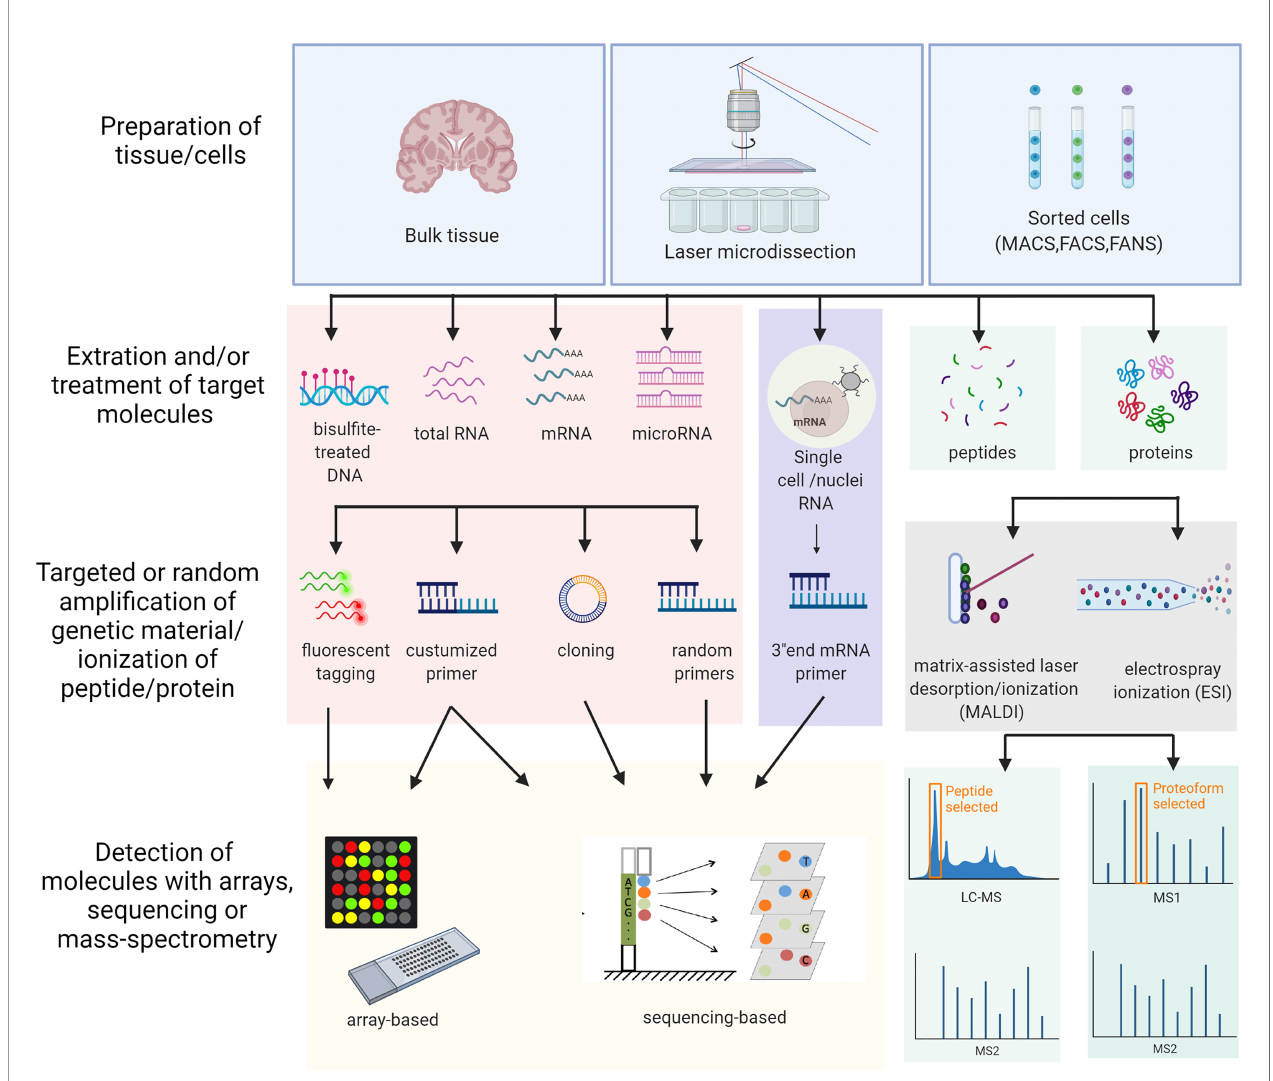
FIGURE 1 | Schematic overview of the different omics approaches used in the study. The overview includes all the different methods used in the studies included in this review. MACS, Magnetic-activated cell sorting; FACS, Fluorescence-activated cell sorting; FANS, Fluorescence-activated nucleus sorting; LC-MS, Liquid chromatography – mass spectrometry. Created with